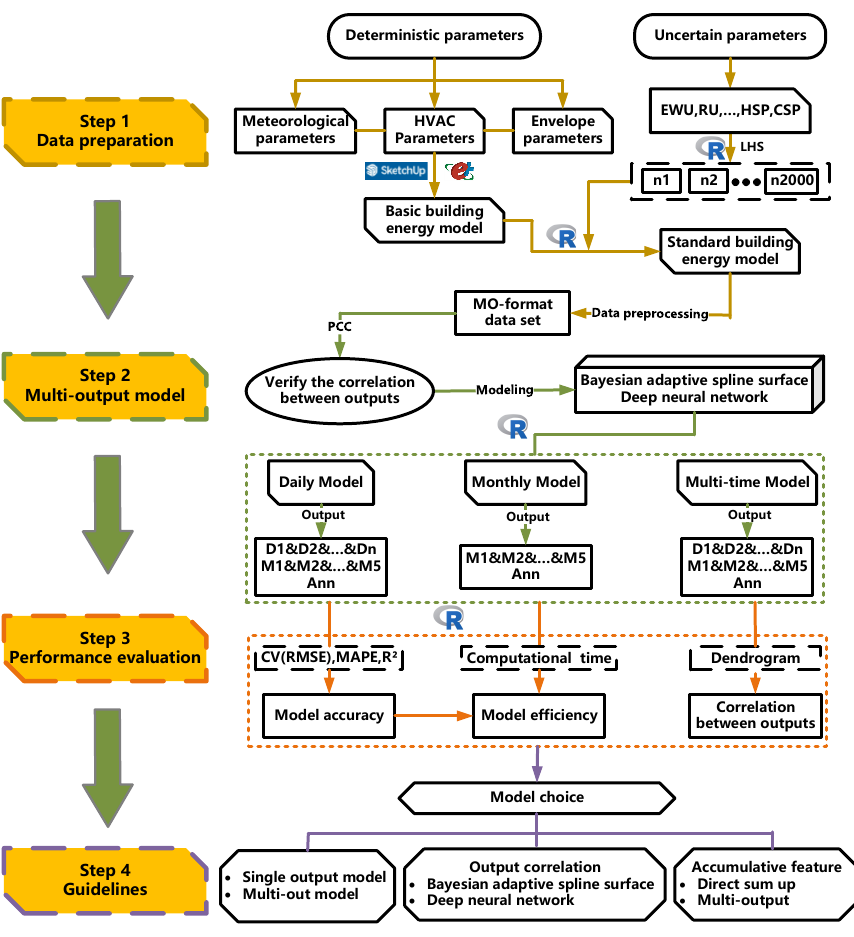
Figure 1. A flow chart of multi-output models of building energy at daily, monthly, and annual scales based on machine learning.